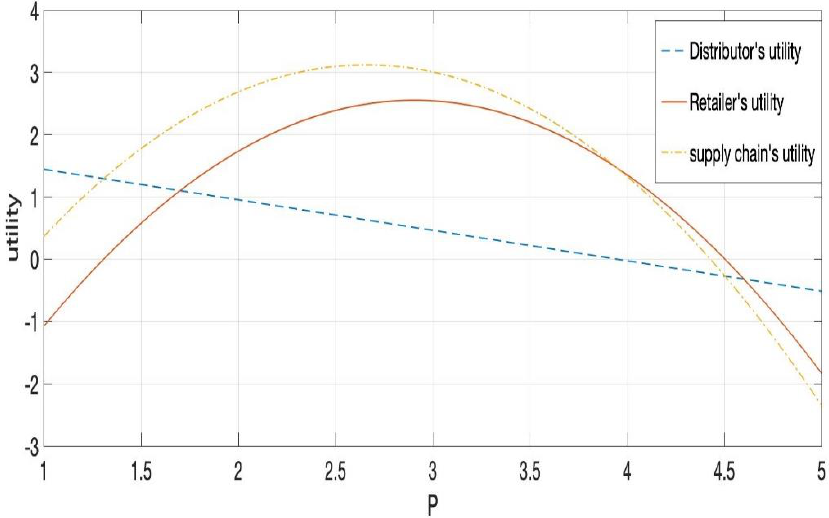
Figure 1. The relationship between the retail price and supply chain profit.